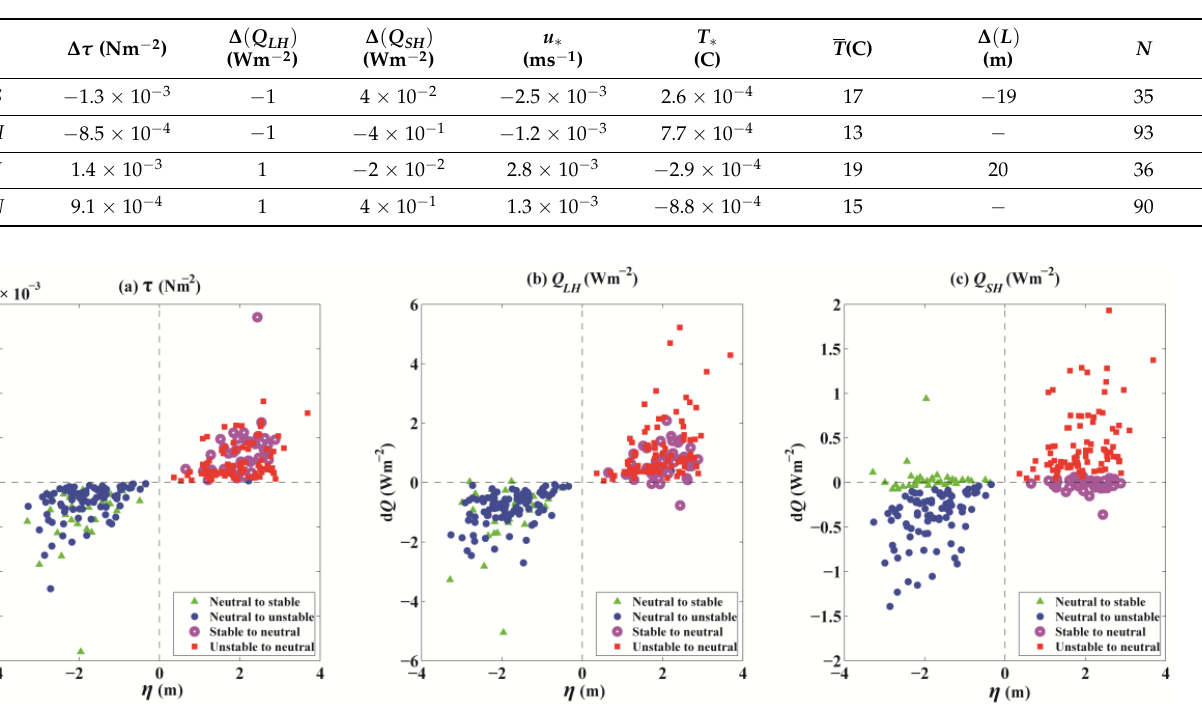
Figure 9. Scatter plots of hourly differences in wind stress (Nm − 2 , ( a )), Q LH (Wm − 2 , ( b )), and Q SH (Wm − 2 , ( c )) between magnitudes with and without the inclusion of SSE ( η , x-axis) along with boundary layer stability (BLS) shifts. Changes in the state of the BLS are marked by different colours and symbols. Green triangles and blue dots represent shifts from near-neutral conditions ( − 0.4 < ξ < 0.1) to stable ( ξ > 0.1) and unstable ( ξ < − 0.4) conditions, respectively, while magenta circles and red squares represent shifts from the stable and unstable boundary conditions to near-neutral conditions, respectively.